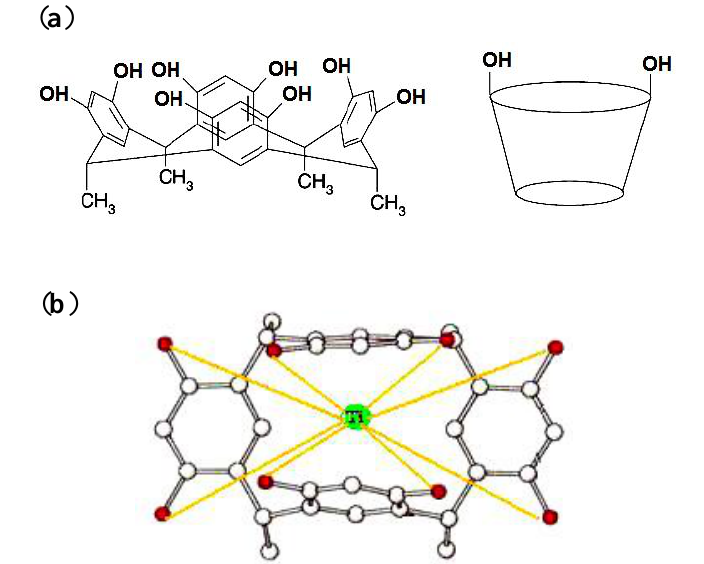
Figure 3. Optimal conformation of CMCR before ( a ) and after ( b ) complexation with Ti(OH)(OH ) 52+ 2